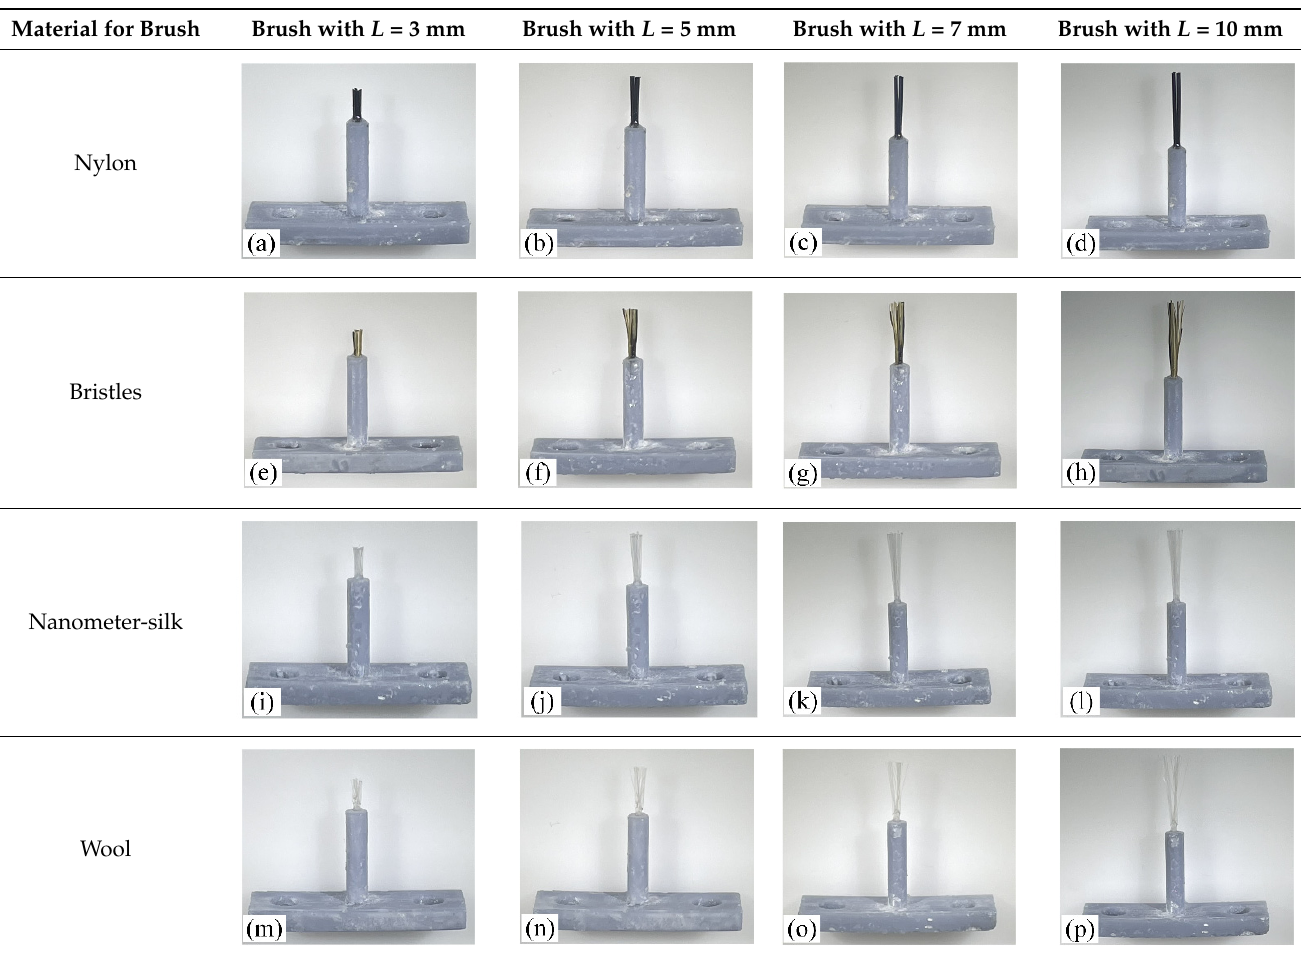
Table 4. Brushing Micro-manipulators made of different materials and lengths.